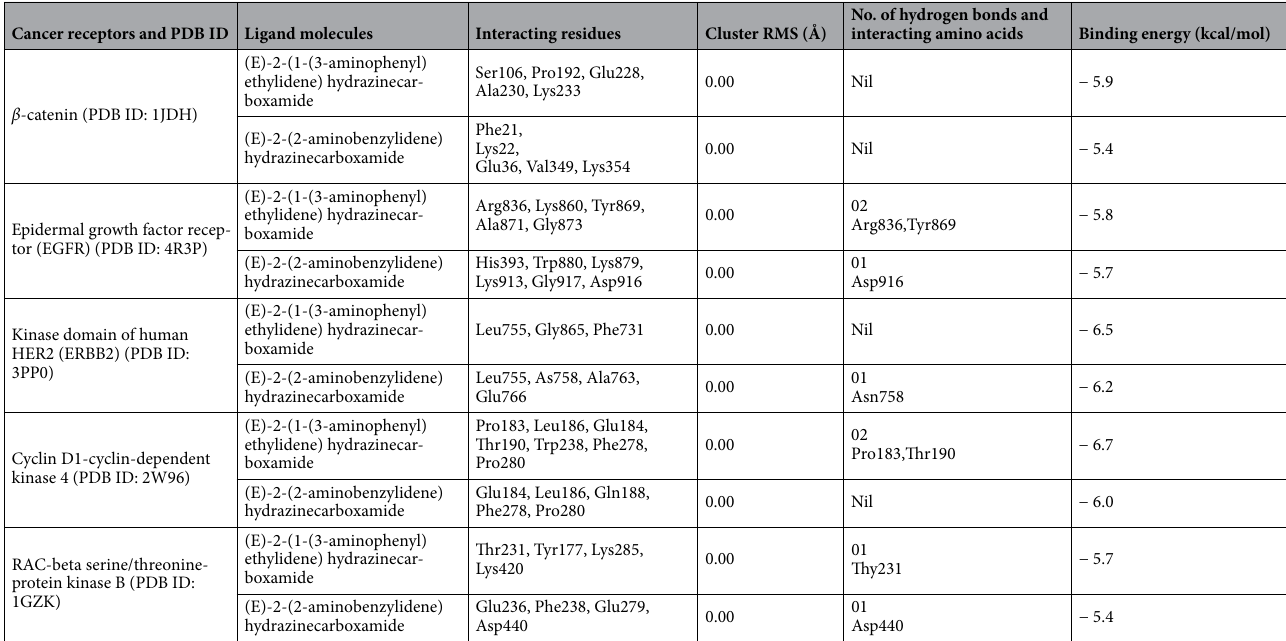
Table 7. The binding potential of (E)-2-(1-(3-aminophenyl) ethylidene) hydrazinecarboxamide and (E)-2-(2- aminobenzylidene) hydrazinecarboxamide towards selected drug targets of various types of cancers predicted by molecular docking studies by AutoDock